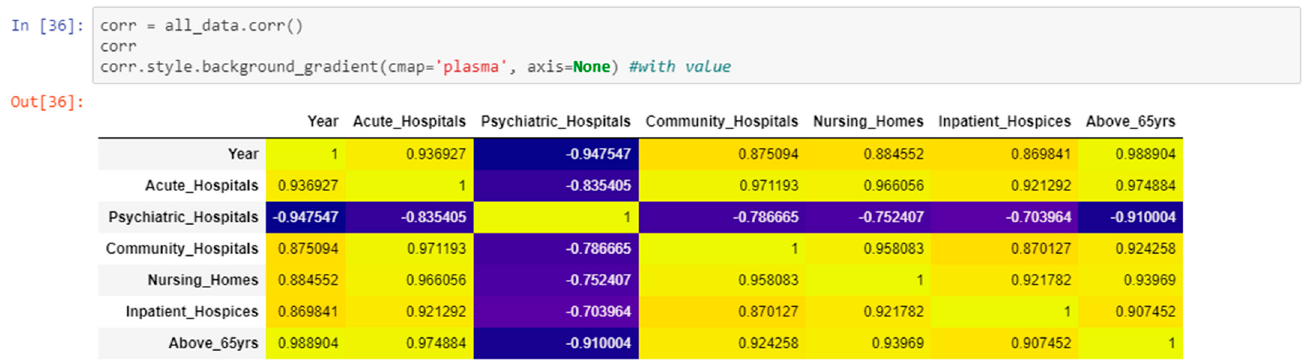
Figure 6. Correlation between eldercare facilities and the resident population aged 65 onwards. Source: Developed for the study.